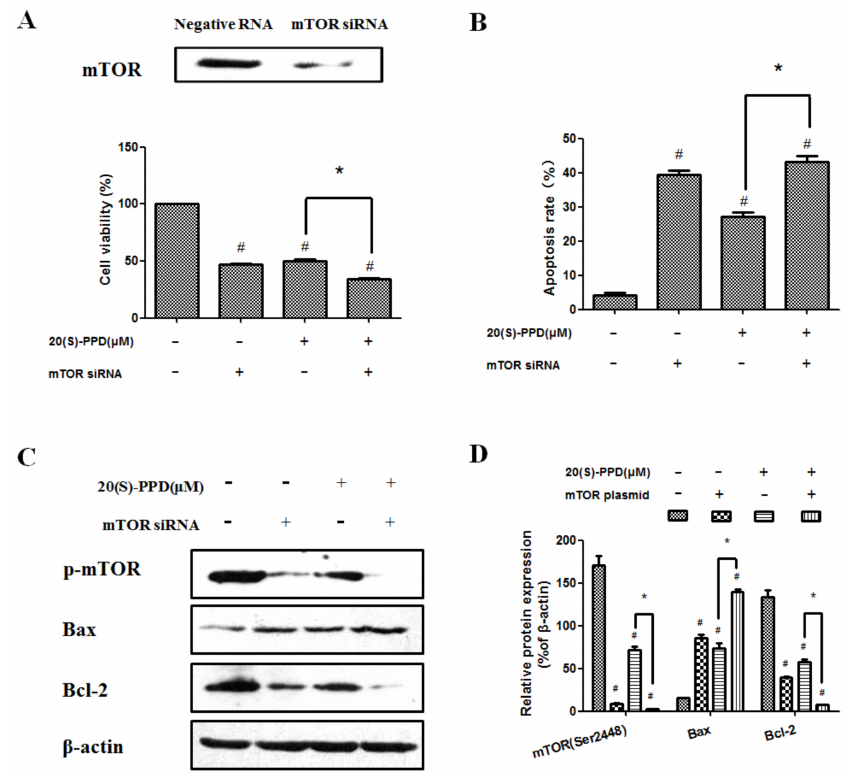
Figure 5. 20(S)-PPD-induced apoptosis was promoted by knockdown of mTOR with siRNA. ( A ) Western blot was used to detect mTOR expression after siRNA transfection (upper line). After 20(S)-PPD (30 µ M) treatment in MCF-7 cells for 24 h, the MTT assay was used to determine the cell viability (lower line). ( B ) Flow cytometry was used to measure the apoptosis rate after 20(S)-PPD (30 µ M) treatment for 24 h. ( C , D ) After 20(S)-PPD (30 µ M) treatment of MCF-7 cells for 24 h, Western blot was used to determine the expression of Bax, Bcl-2, and p-mTOR. All data presented